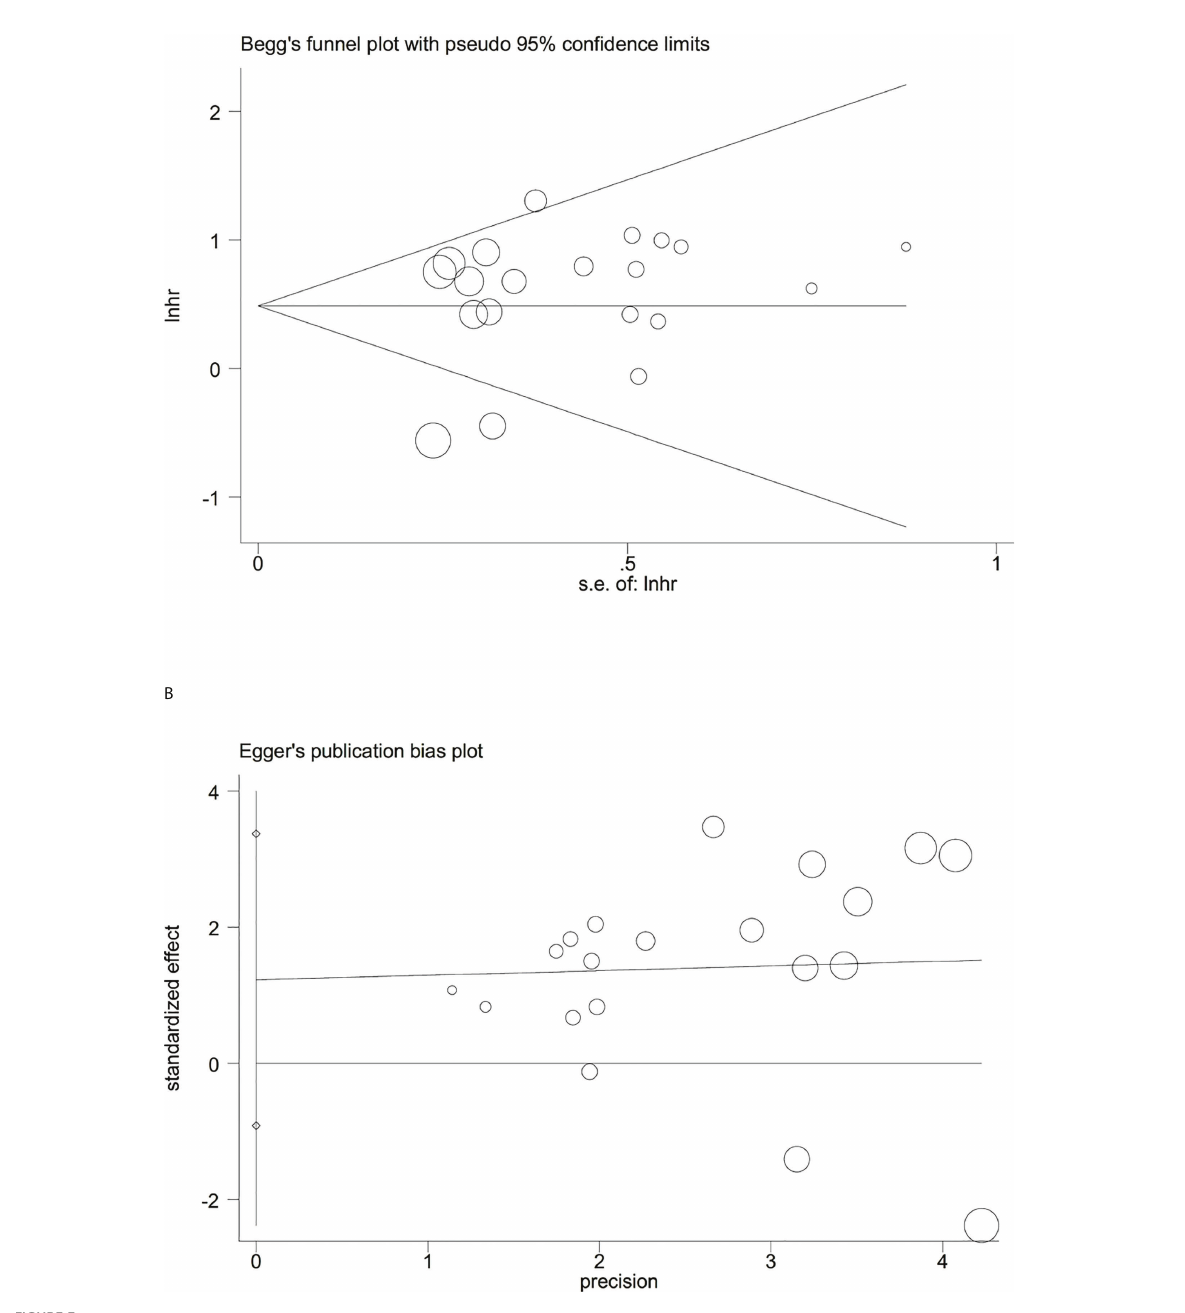
FIGURE 3 Evaluation of publication bias between the expression levels of glycolysis markers and overall survival. (A) Begg ’ s funnel plot, P =0.871; (B) Egger ’ s test, P